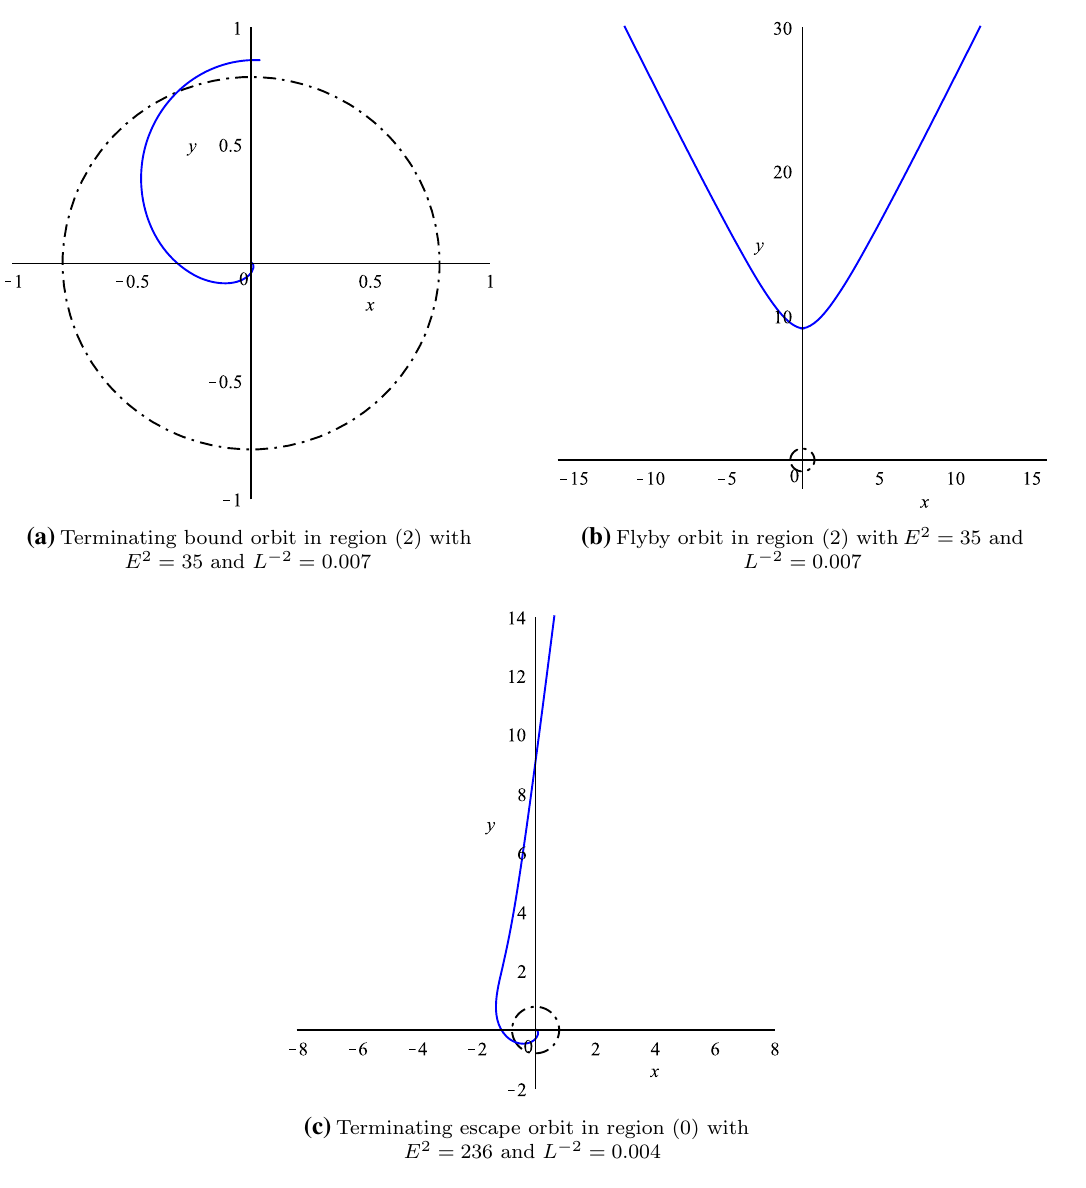
Fig. 10 Null geodesics in the uncharged BTZ black hole in massive gravity with (cid:4) = 0 . 01, m (cid:5) = 2 . 54 and m 0 = 2. The dashed dot line represents